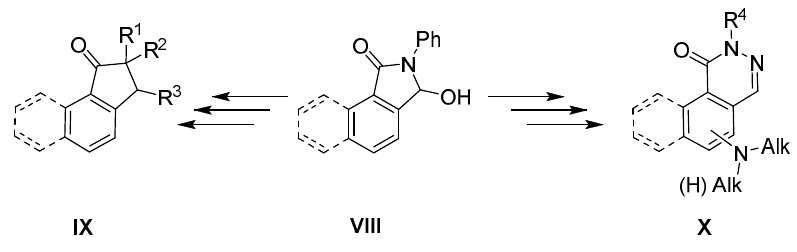
Figure 1. Biologically active isoindolinone and indanone derivatives.